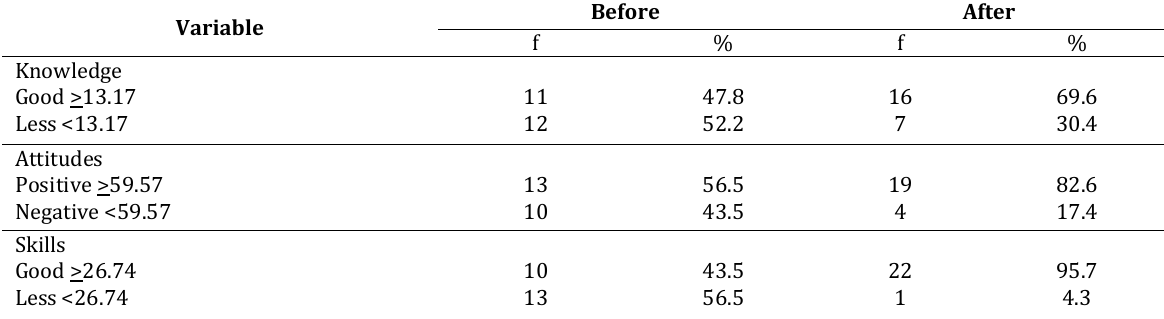
Table 2. Distribution of Knowledge Level Description, Attitude and Skills of Caregivers Before and After Self- Care Training (n= 23)